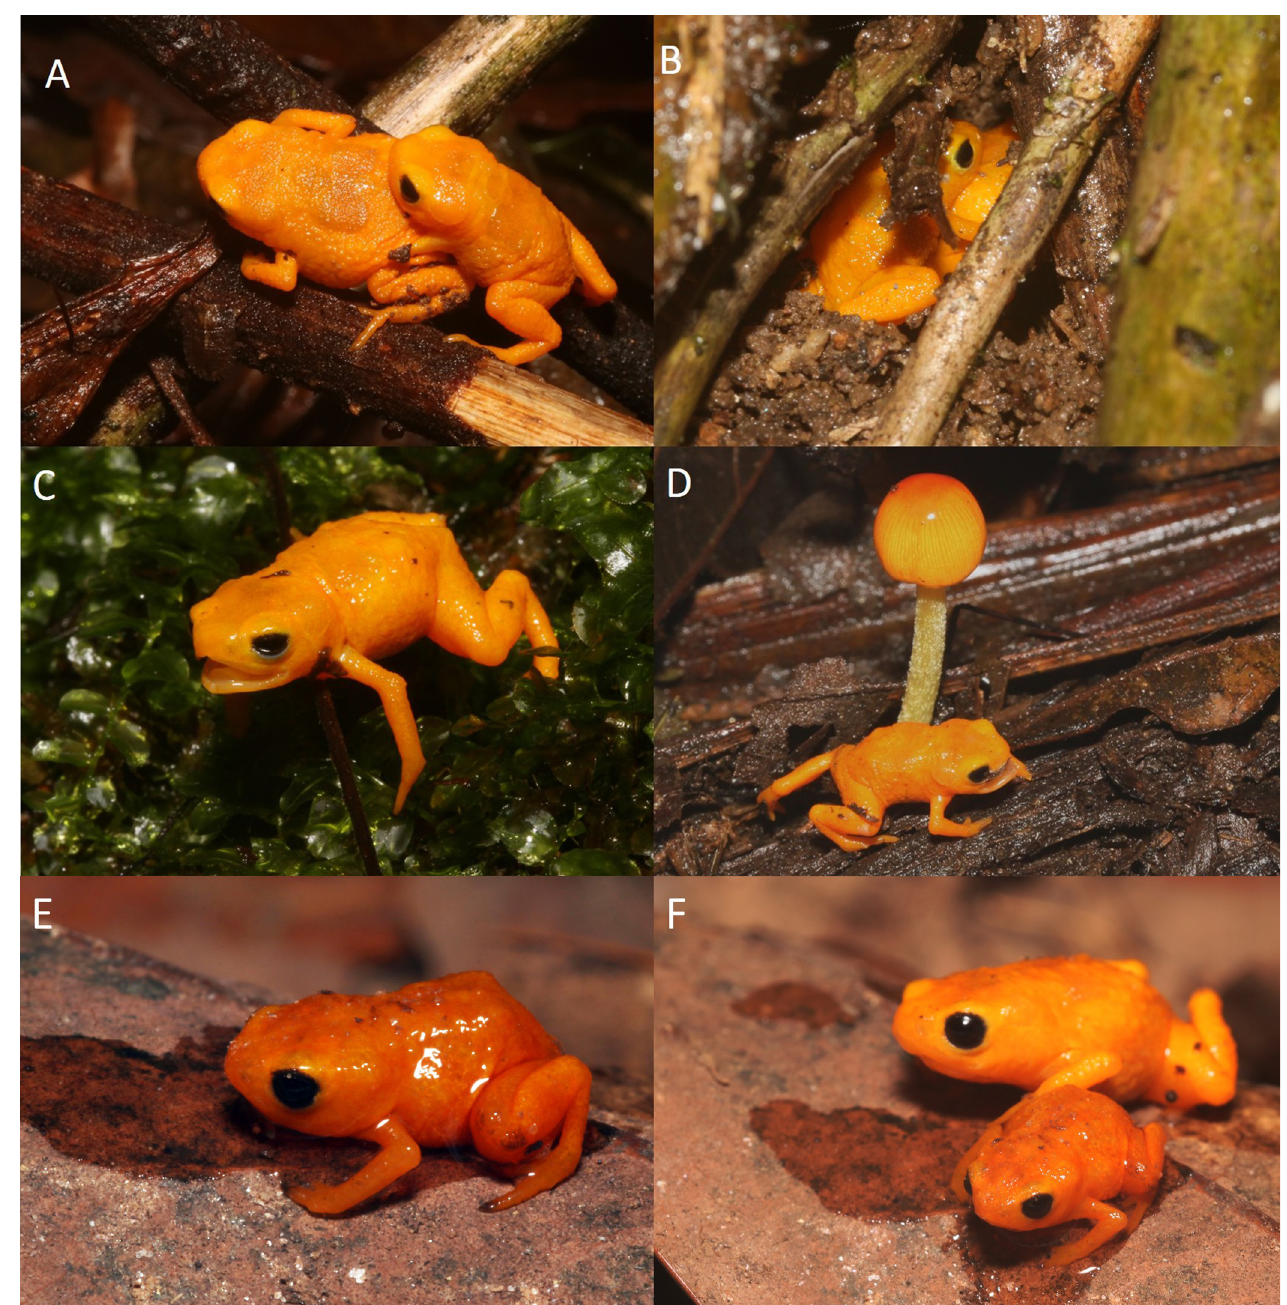
Fig 10. Natural history observations of Brachycephalus rotenbergae sp. nov. (A) Inguinal amplexus; (B) An amplected couple of hiding under the juc¸ara palm ( E . edulis ) root system; (C) Mouth gaping defensive behaviour; (D) One specimen near a yellow/orange mushroom, notice the similarity of color and size; (E) One juvenile specimen; (F) Two juvenile specimens, but the smaller one is darker.